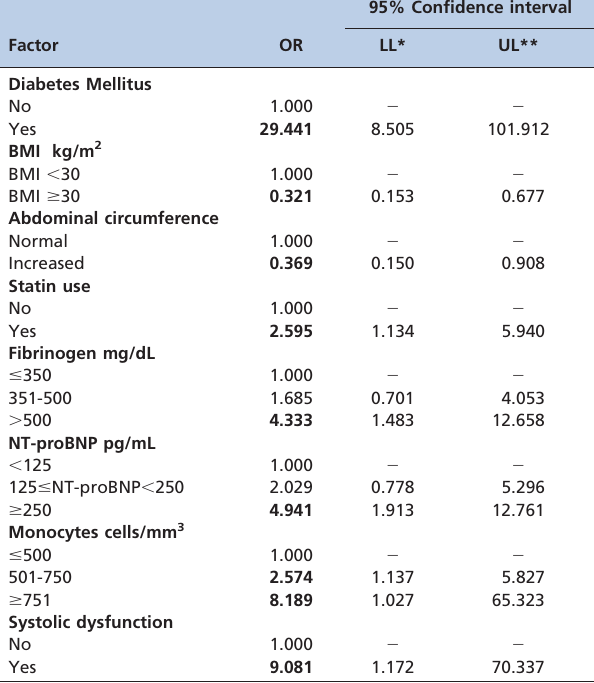
NT-proBNP and monocytes were associated with angio- graphic CAD, regardless of whether categorical or quantita- tive variables were considered (Tables 3 and 5). Table 4 - Odds ratios for categorical variables significantly associated with the presence of angiographic coronary